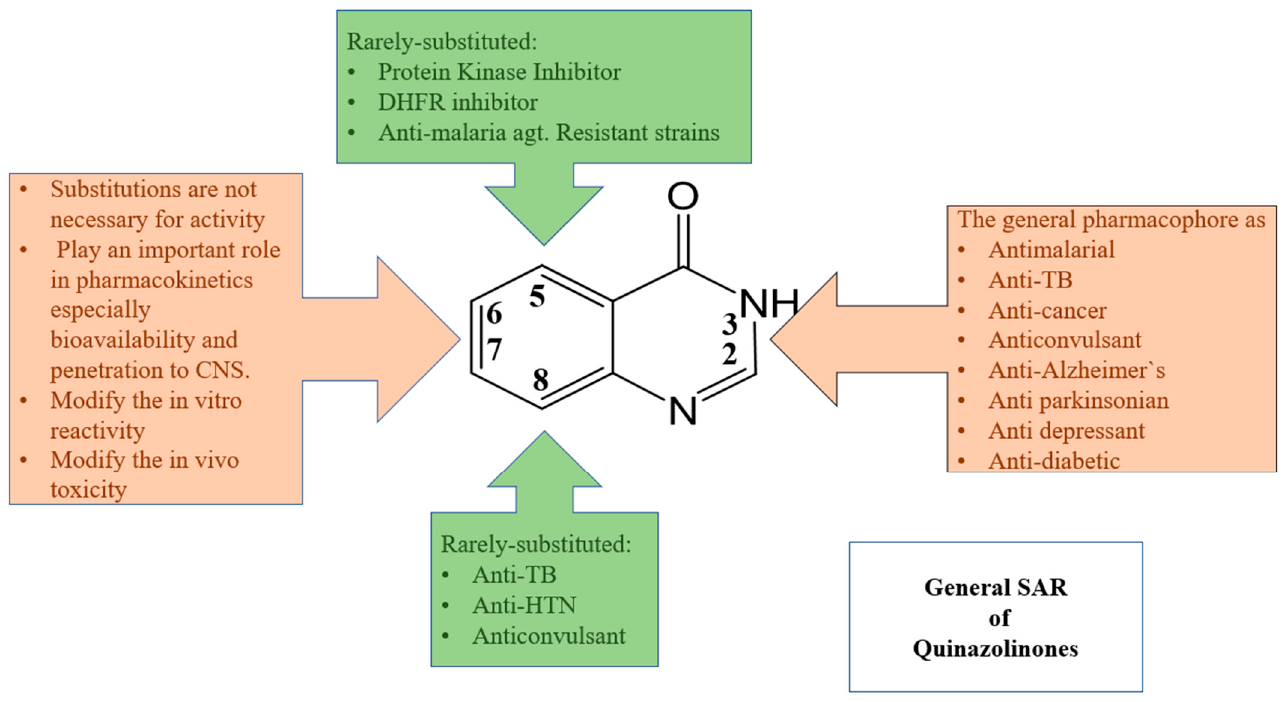
Figure 9 . Summary of SAR of quinazolinones. Figure 9. Summary of SAR of